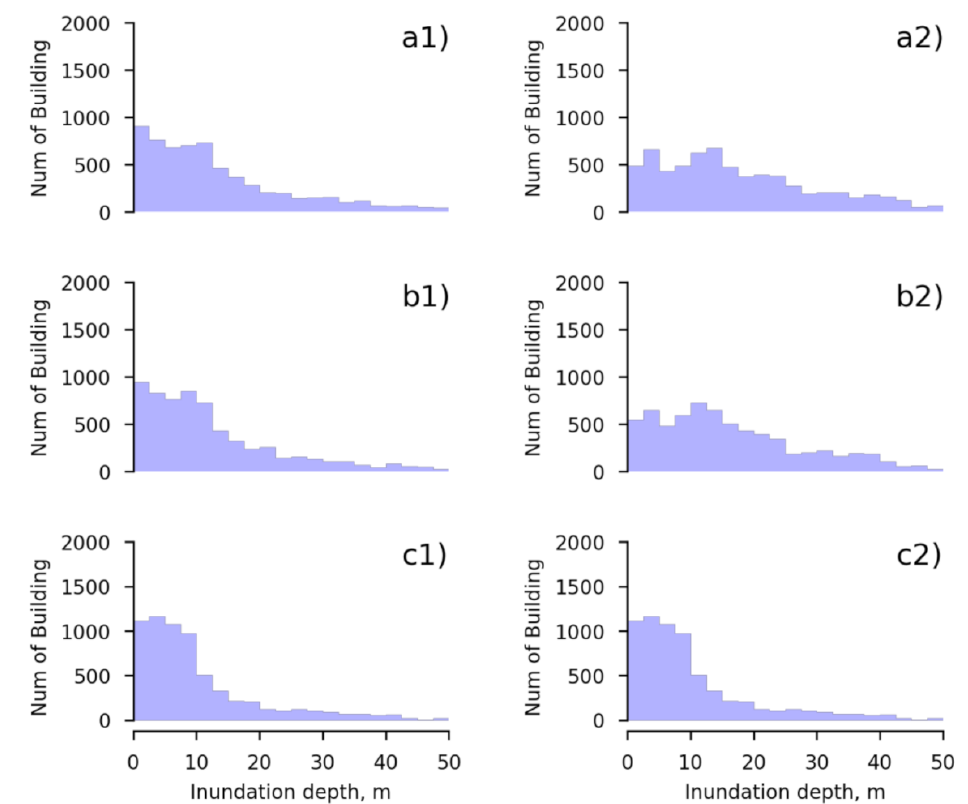
Figure 11. Summary of the number of buildings in each inundation depth range of 2.5 m in the whole inundated building around the coastal area of Taal Lake. ( a ) 1/1000 probability, ( b ) 1/500 probability and ( c ) 1/100 probability; the right column corresponds to the northern area and the left column corresponds to the southern